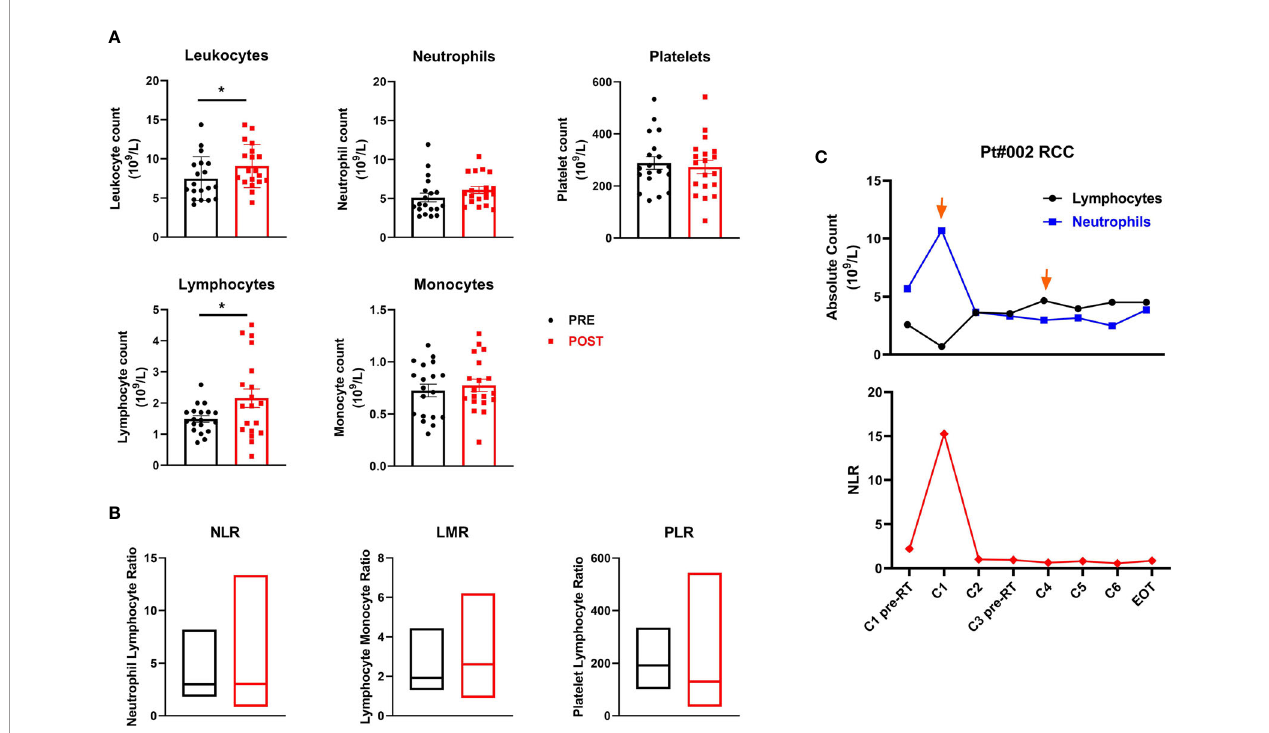
FIGURE 4 | Peripheral blood cell biomarkers of immune modulation. (A) Scatter plots with bars represent leukocyte, neutrophil, platelet, lymphocyte and monocyte counts (10 9 /L) in peripheral blood collected before and after therapy. Data represent individual values, mean (central bar) ± SEM (upper and lower bar). The black circular dots represent pre- therapy samples, while the red squares represent post-therapy samples. (B) Boxes with fl oating bars represent neutrophil-to-lymphocyte ratio (NLR), lymphocyte-to-monocyte ratio (LMR) and platelet-to-lymphocyte ratio (PLR). The black and red boxes represent pre- and post-therapy values, respectively. (C) Trend of the absolute count of lymphocytes and neutrophils (upper panel) and the NLR (lower panel) during treatment cycles for patient #002 (RCC, partial responder). The black line and dots refer to the lymphocyte count, the blue line and dots to the neutrophil count and the red line and dots to the NLR. Statistical analysis was performed with the nonparametric Wilcoxon signed rank test; * p value <